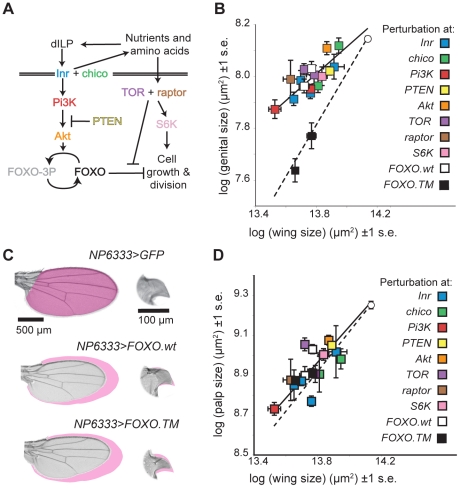
The mechanisms that reduce the insulin sensitivity of the genitalia act at FOXO in the IIS pathway.(A) The insulin-signaling pathway. (B) The effect of different IIS pathway mutations/perturbations on wing and genital size. White circle is well-fed wild-type size, and dotted line indicates where perturbation reduces genital and wing size equally. Perturbations of IIS upstream of activated FOXO, including expression of wild-type FOXO (FOXO.wt) (white squares) causes less of a size reduction of the genitalia than the wing of well fed flies and genocopy dietary restriction. In contrast, expression of constitutively active FOXO (FOXO.TM) (black squares) causes an equal reduction in both organs. Multiple markers of the same color refer to different perturbations of the same gene. (C) The effect of FOXO.wt and FOXO.TM expression on wing and genital arch size. Note that only expression of FOXO.TM causes a substantial reduction in genital size. Magenta shading shows area measured on control organ. Within an organ, all images are at the same scale. (D) In contrast, all these IIS pathway mutations/perturbations, including expression of FOXO.TM (black square) cause a more-or-less equal reduction in the size of the maxillary palps and the wings. Error bars are 1 standard error.